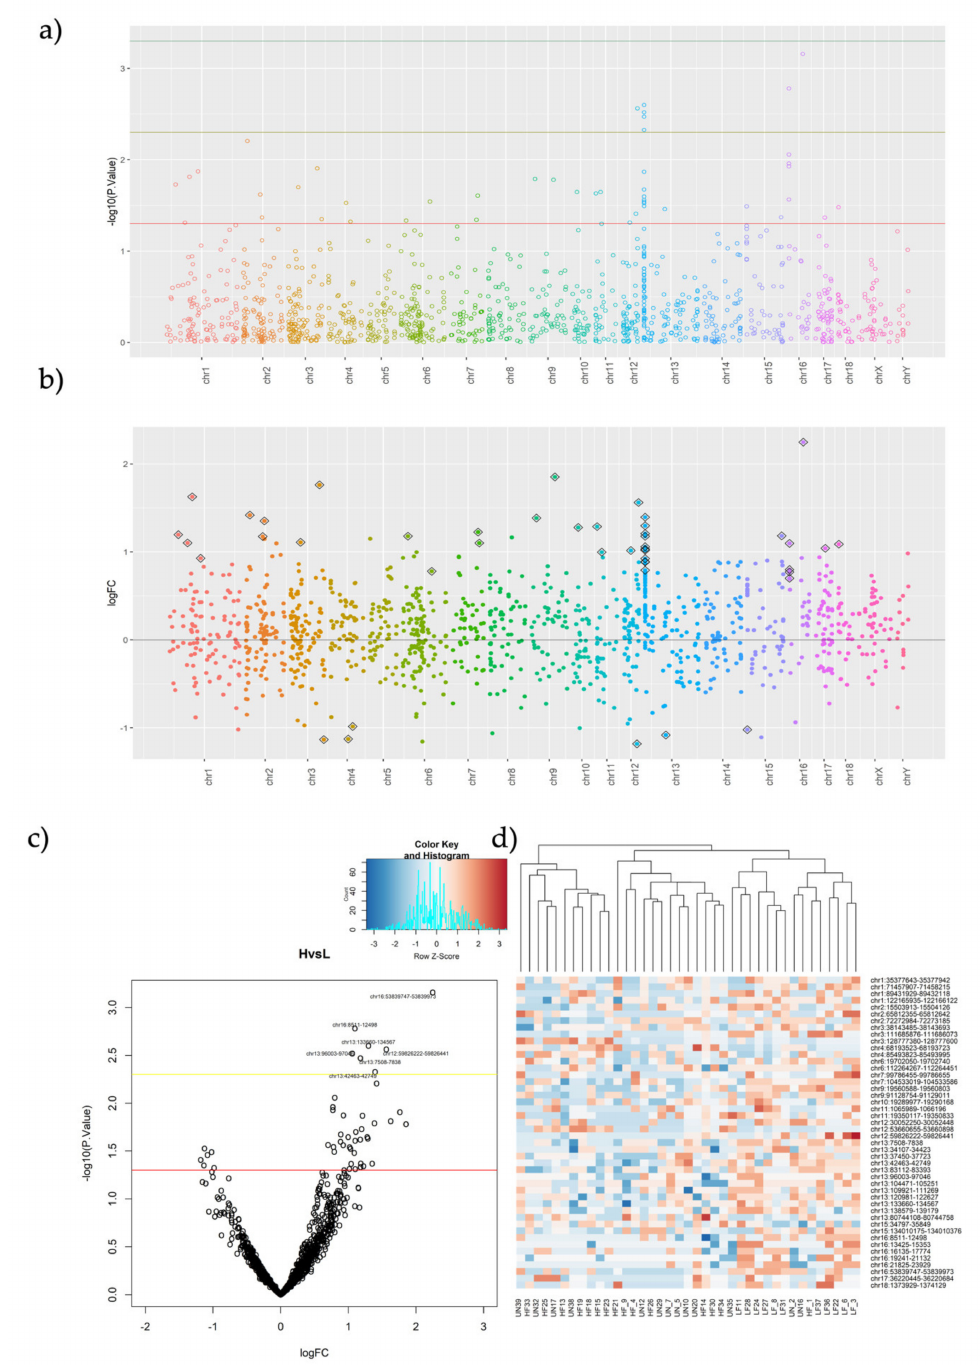
Figure 4. ( a – d ) Manhattan ( a ) and ( b ), volcano ( c ) plots, and heat map ( d ) showing fertility-related DMRs found between HF and LF experimental boar groups. Plots represent − log 10 of p -Values ( a ) and fold-changes ( b ); the diamond ( b ) and heatmap represents only significant DMRs ( d ), which is also represented by the red threshold ( a